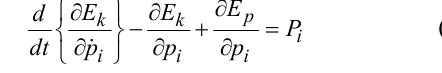
problem Disturbance Observer design Setting gain